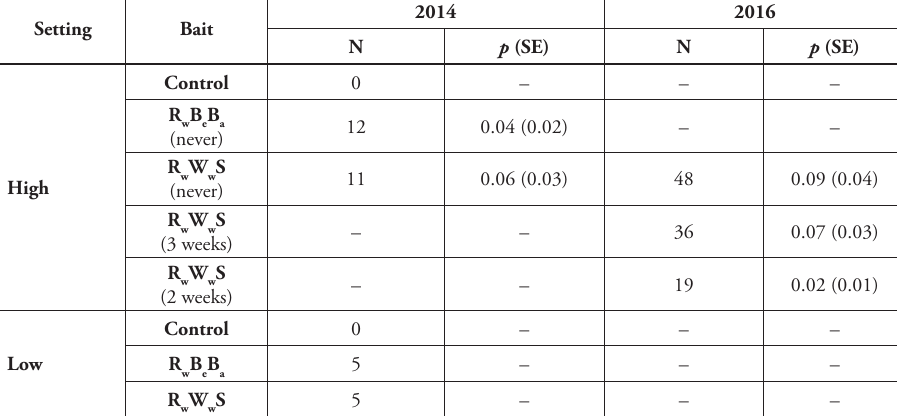
Table 7. Summary of the number of captures (N) by baited traps and relative detection probability ( p ) (Standard Error in brackets), for setting position of the trap (High: above 10 m; Low: 1.5–2 m) and for the type of bait (R B B : Red Wine, Beer, Banana; R W S: Red Wine, White Wine, Sugar; Control: empty w e a w w traps used as control). Change of the mixture is indicated in brackets when expected (3 weeks: changed once during the season; 2 weeks: changed twice during the season; never: never changed during the